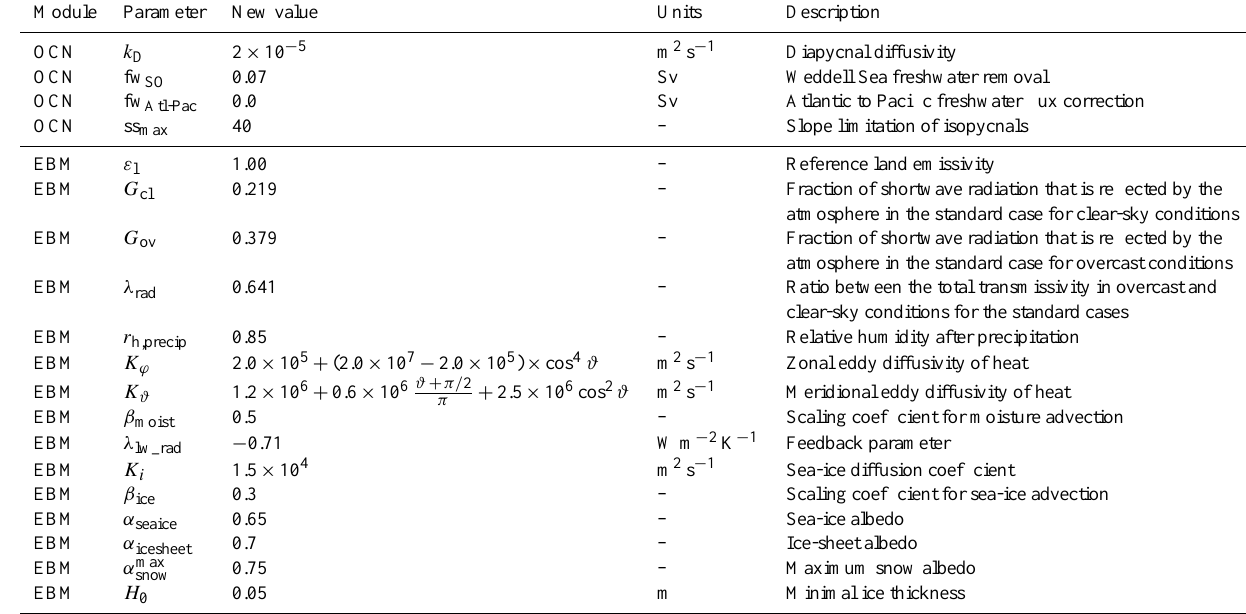
Table A1. Parameters in the ocean (OCN) and energy-balance atmosphere (EBM) modules that changed with respect to the parameters listed in Ritz et al. (2011a).